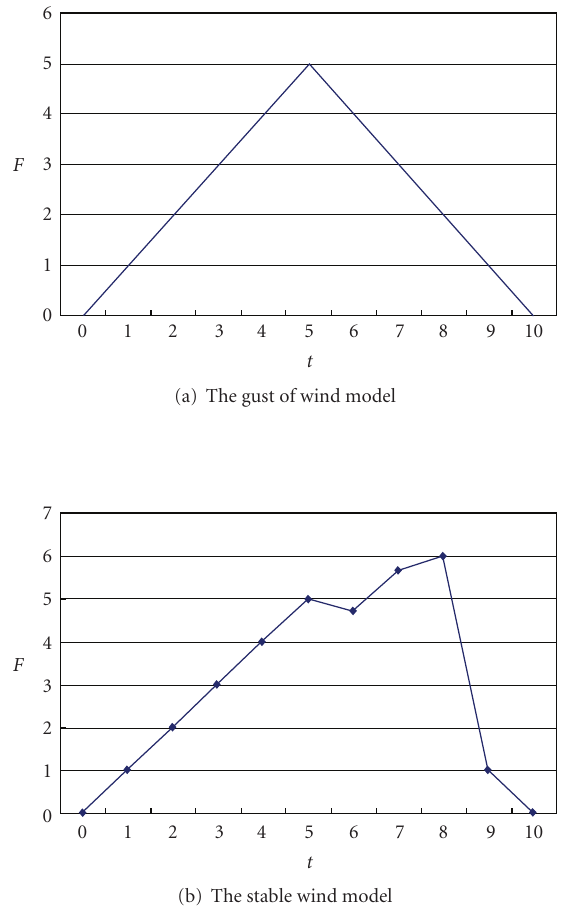
Figure 5: The relationship between the wind force and the